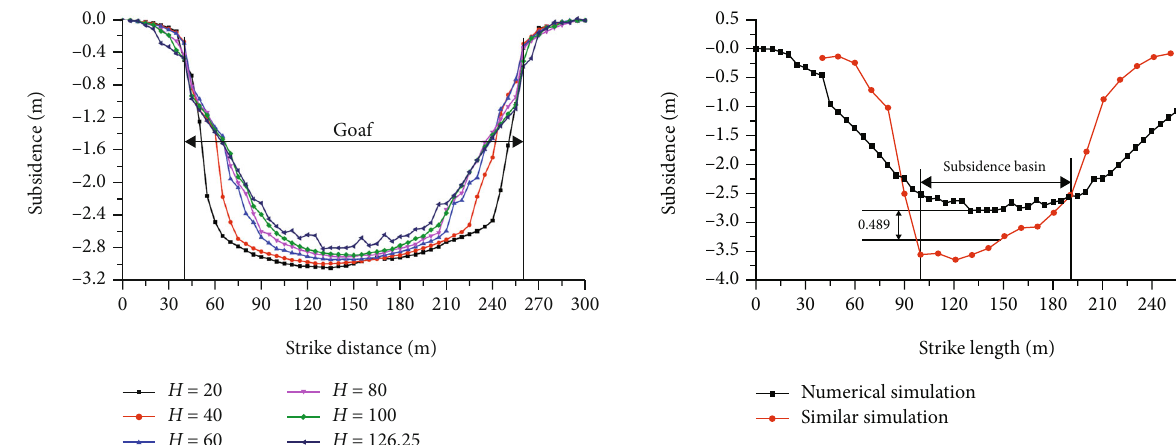
Figure 10: Comparison of numerical simulation and physical simulation